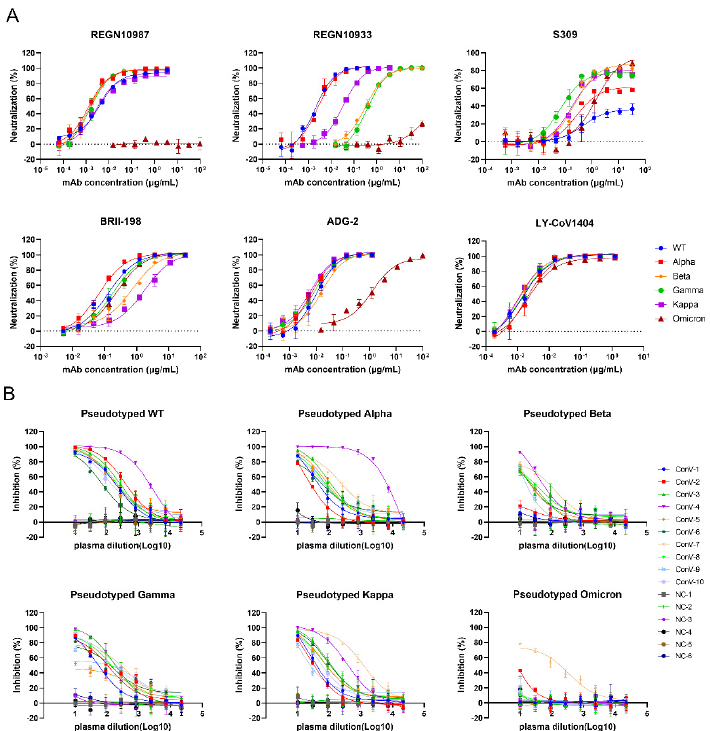
Figure 3. Validation of the neutralization sensitivity of SARS-CoV-2 pseudotyped variants. ( A ) Neu- tralizing curves of monoclonal antibodies against pseudotyped SARS-CoV-2 variants. Data are representative of at least two independent experiments. Mean ± SD was shown. ( B ) The inhibition activity of ten COVID-19 convalescent plasma samples against pseudotyped SARS-CoV-2 variants. Six plasma samples from healthy individuals were tested as negative controls (NC). The initial di- lutions for both positive and negative samples were 1:10, followed by a 3-fold serial dilution. Sam- ples were tested in triplicates and the experiments were repeated at least twice. Data from one of at least two independent experiments are presented in Mean ± SD.